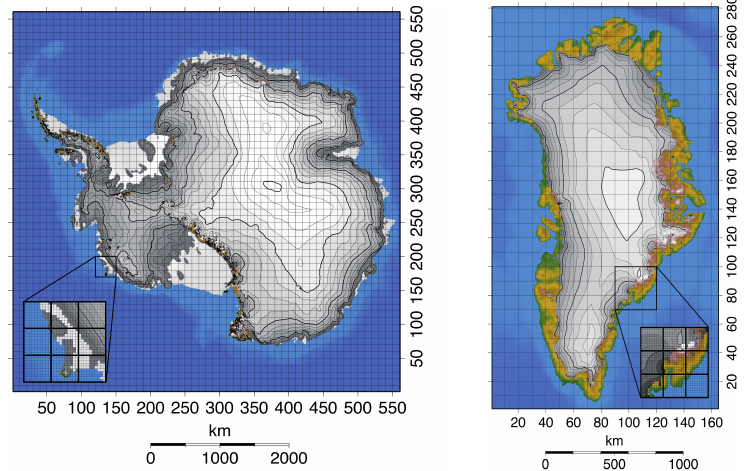
Fig. 7. The numerical grid of AGISM has a horizontal resolution of 10km for both polar ice sheets (left panel: Antarctic ice sheet; right panel: Greenland ice sheet). Major gridlines are for a distance of 100km, the insets show the detailed meshes employed in the calculations. The numbers along the axes are gridpoint numbers (561 × 561gridpoints for AISM, 165 × 281 for GISM). For illustrative purposes, we display observed surface elevation of the present-day ice sheets. Ice sheet cover is shaded grey, ice-free range from green to white, and blue colours depict the ocean. Contour lines over the ice sheets are for every 250m of elevation, major ones for every 1000m are shown in